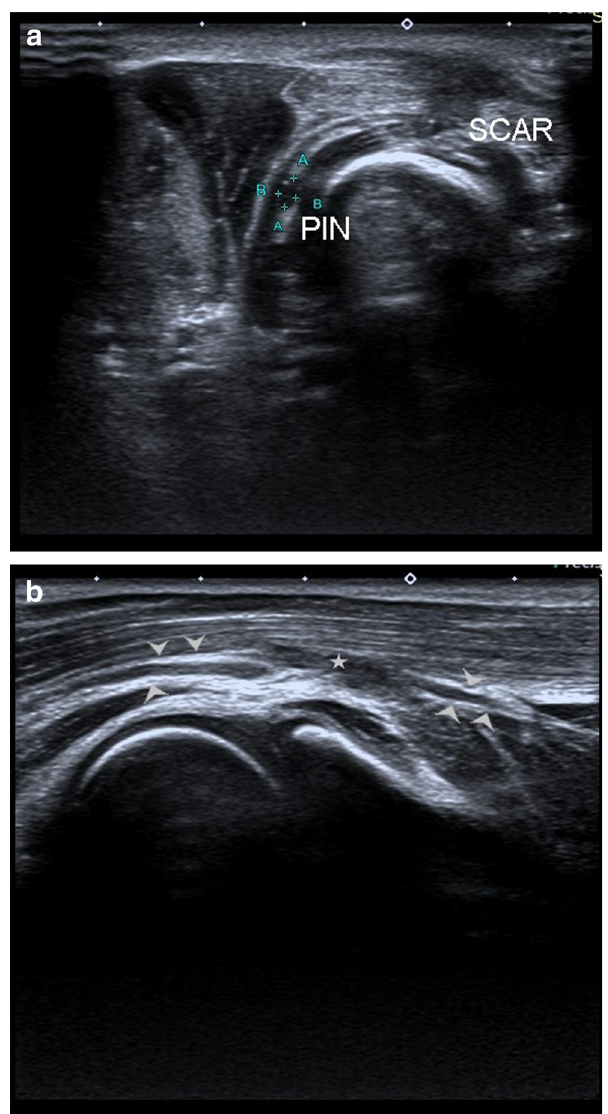
Fig.5 a High-resolution ultrasound image ofa patient who had history of penetrating injury distal to the elbow. SCAR denotes the hypoechoic scar tissue formed within soft tissue at the site of injury. The posterior interosseous nerve (PIN) is normal at the level of local scar. b Image shows discontinuity in posterior interosseous nerve in the forearm with formation of hypoechoic scar tissue (stars), distal to the site of scar on skin. The nerve (arrowheads) is of normal calibre proximally and